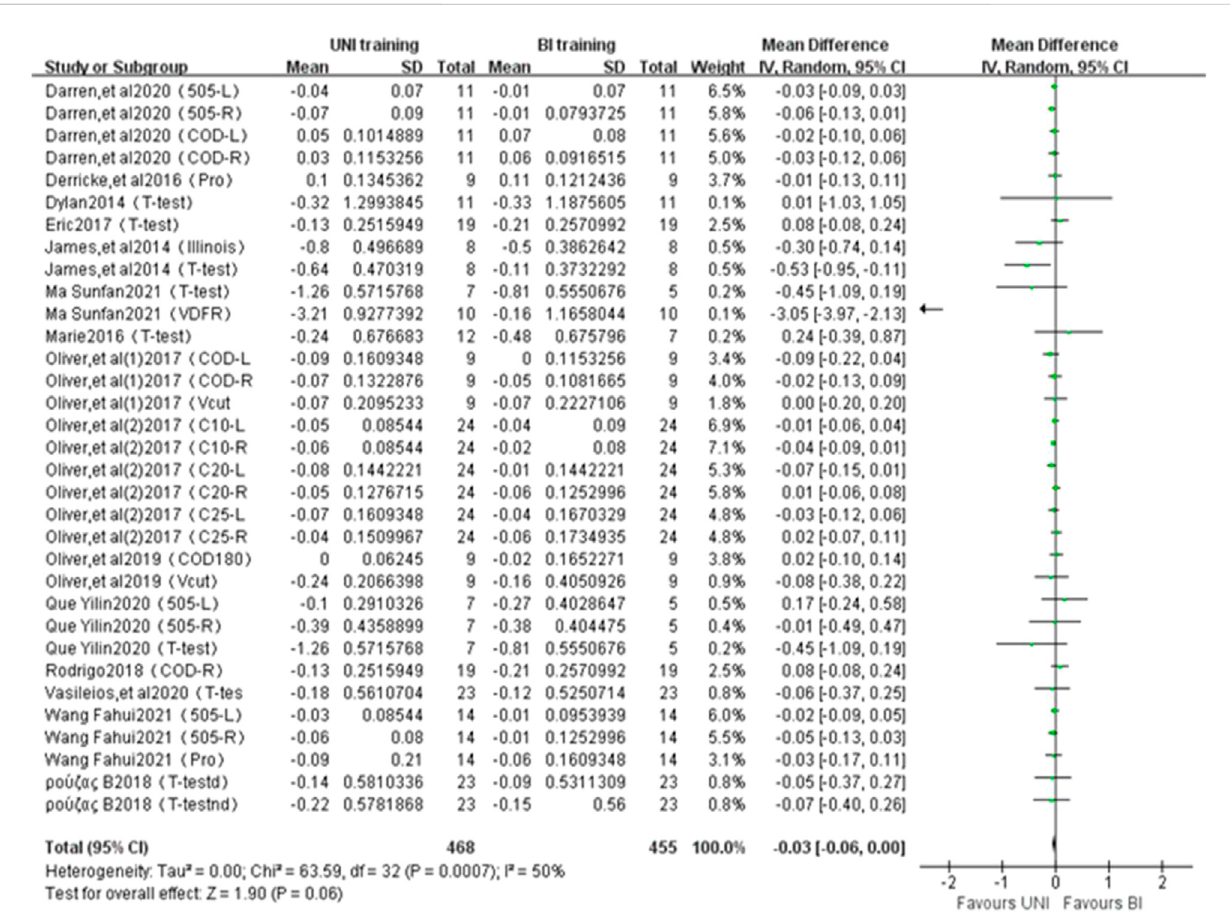
FIGURE 5 Intergroup Forest plots of UNI and BI training affecting Change of Direction Ability. 505-L = 505 change-of-direction speed test with left leg; 505- R= 505change ofdirectionspeed testwith rightleg; COD = change-of-direction test; Pro =pro-agility test; COD180 =time in5+ 5 m sprint change of directionof180 ° ;COD180d=timein5+5 msprintchangeofdirectionof180 ° withdominantleg;COD180d=timein5+5 msprintchangeofdirection of 180 ° with non-dominant leg; COD90d = time in 5 + 5 m sprint change of direction of 90 ° with dominant leg; COD90d = time in 5 + 5 m sprint change of direction of 90 ° with non-dominant leg; COD-L = change-of-direction test with left leg; COD-R = change-of-direction test with right leg; Illinois = Illinois test; V-cut = 25-m sprint with 4 changes of direction of 45 ° ; C10-L = 10 m with left leg with a COD of 180 ° ; C10-R = 10 m with right leg withaCODof180 ° ;C20-L=20 mwithleftlegwithaCODof180 ° ;C20-R=20 mwithrightlegwithaCODof180 ° ;C25-L=25 mwithleftlegwithaCOD of 180 ° ; C25-R = 25 m with right leg with a COD of 180 ° ; t -test = T- fi gure route agility test; t -test = T- fi gure route agility test with dominant leg; t -test = T- fi gure route agility test with non-dominant